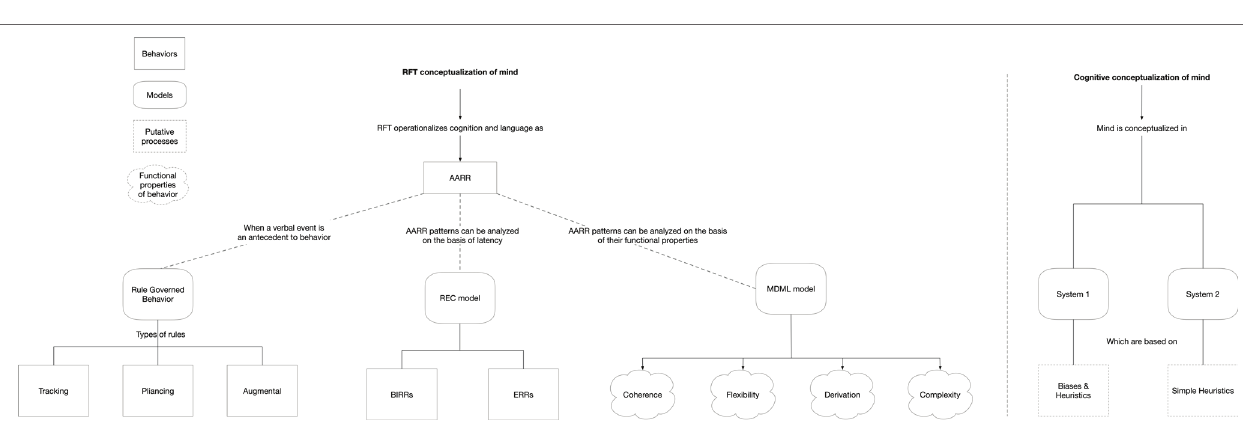
FIGURE 3 | Commonalities between RFT and cognitive conceptualizations of